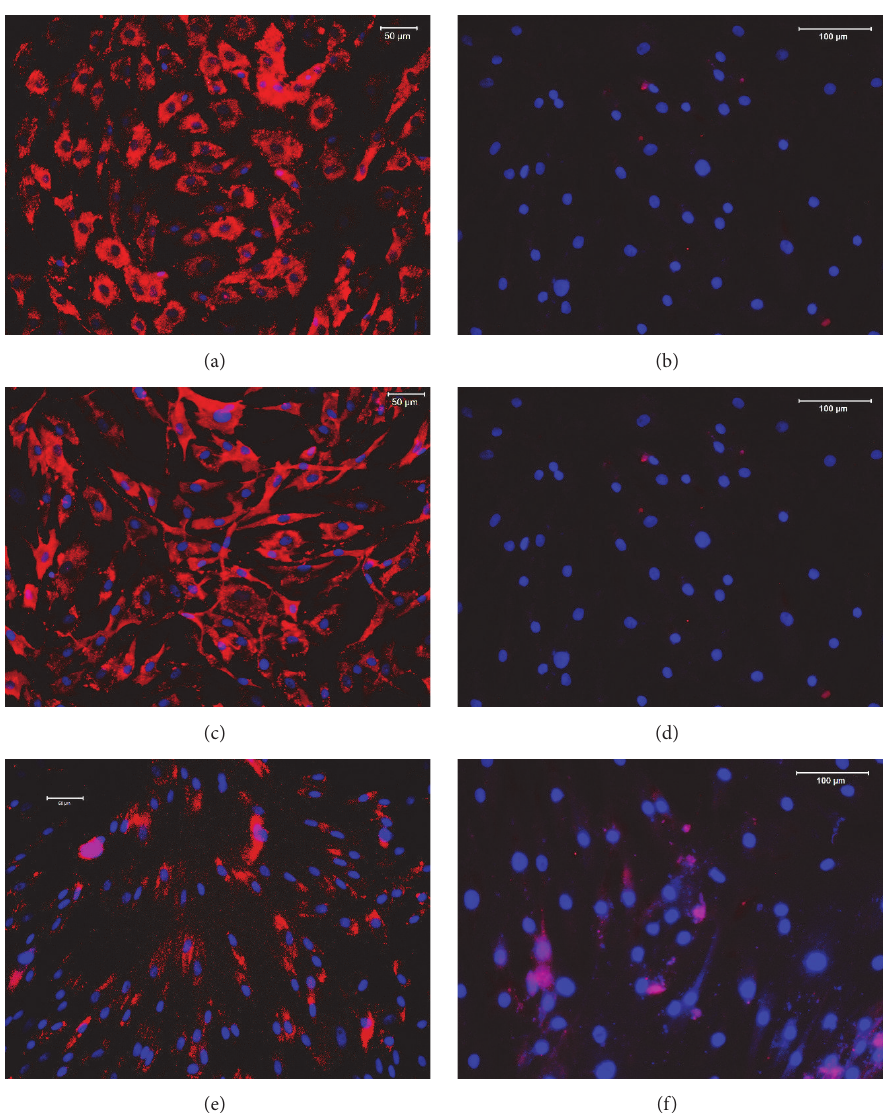
Figure 3: Stem cell marker expression in ADSCs. The stem cell markers in ADSCs were identified by specific antibody reactions with CD44 (a), CD31 (b), CD90 (c), CD34 (d), CD73 (e), and CD45 (f), respectively. More than 90% of ADSCs were positively stained by CD44 (a) and CD90 (c). However, less than 70% of ADSCs expressed CD73 (e), and less than 20% of ADSCs exhibited CD45 (f). On the other hand, very few ADSCs were positively stained by CD31 (b) and CD34 (d). The images were obtained by an inverted fluorescent microscope. Bars: 100 𝜇